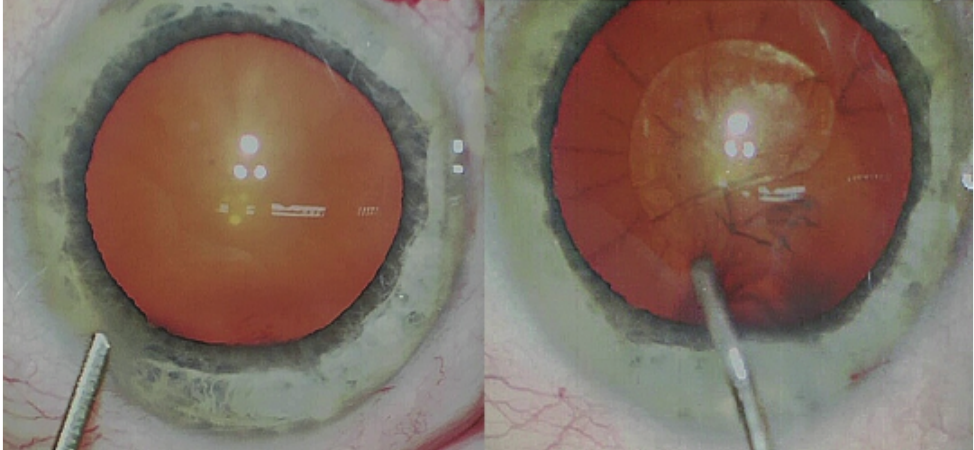
Figure 1. Spike-like staining of the crystalline lens (arrows) following intracameral injection of phenylephrine hydrochloride.